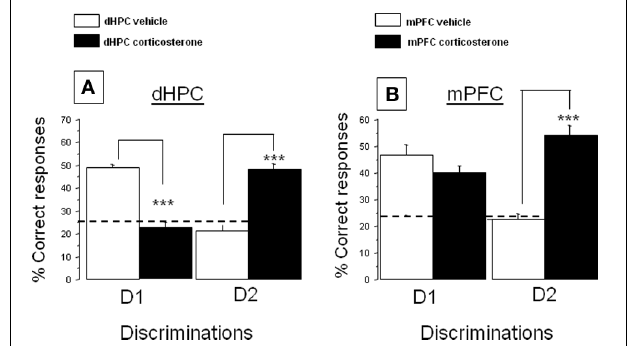
FIGURE 4 | Effect of corticosterone injections into the dHPC or mPFC on the % correct responses in the CSD task. (A) dHPC First discrimination, D1: corticosterone injected into the dHPC significantly decreases the % correct responses as compared to vehicle-injected mice ( ∗∗∗ p < 0 . 001); Second discrimination, D2: corticosterone injected in the dHPC increased the % of correct responses as compared to vehicle-treated control group ( ∗∗∗ p < 0 . 001); (B) First discrimination, D1: corticosterone injected into the mPFC has no significant effect as compared to vehicle-treated group; Second discrimination, D2: corticosterone injected into the mPFC increased the % of correct responses as compared to the vehicle-treated control group ( ∗∗∗ p < 0 .